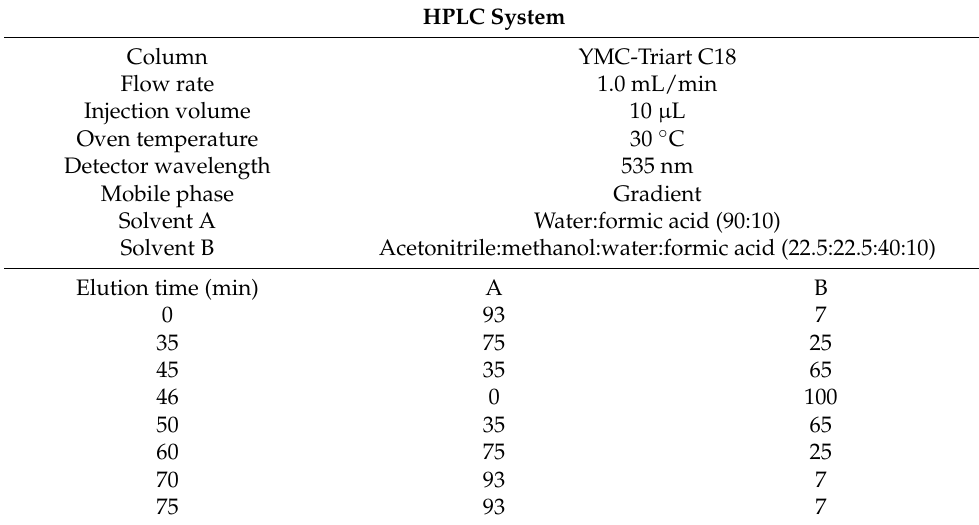
Table 4. The conditions of HPLC analysis of C3G and C3R.